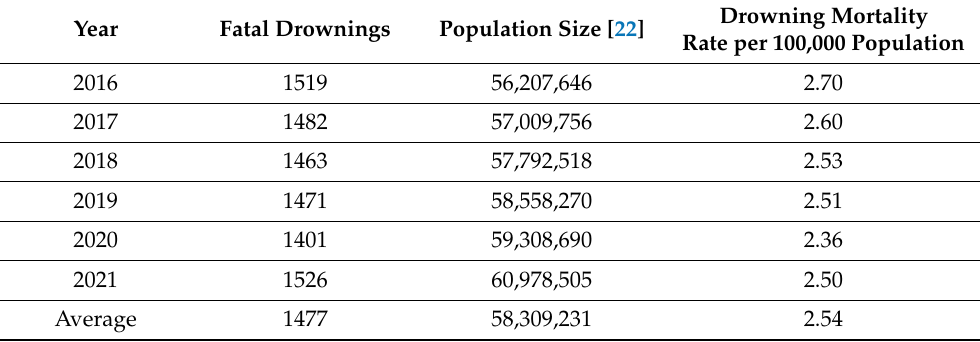
Table 1. Drowning mortality rates per annum in South Africa, 2016–2021.